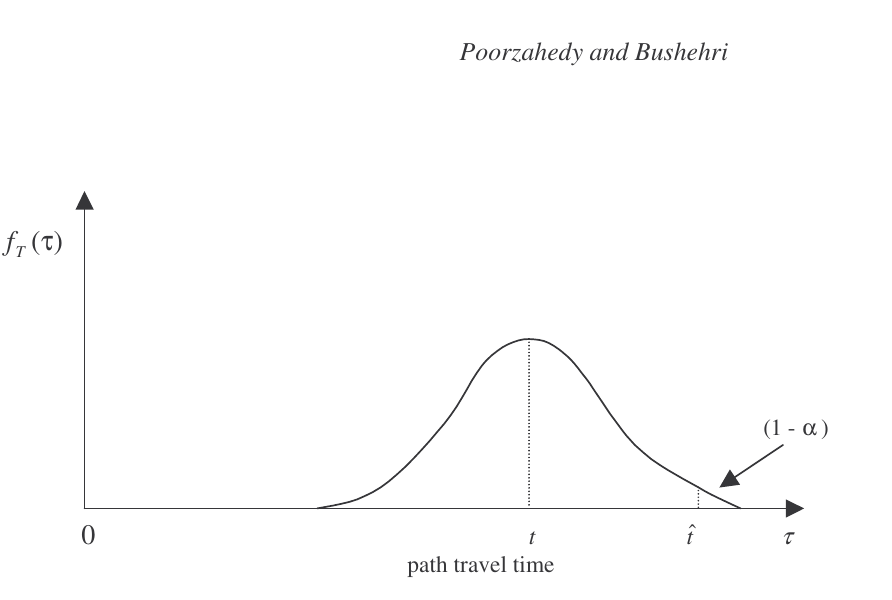
Figure 2. Path travel time density